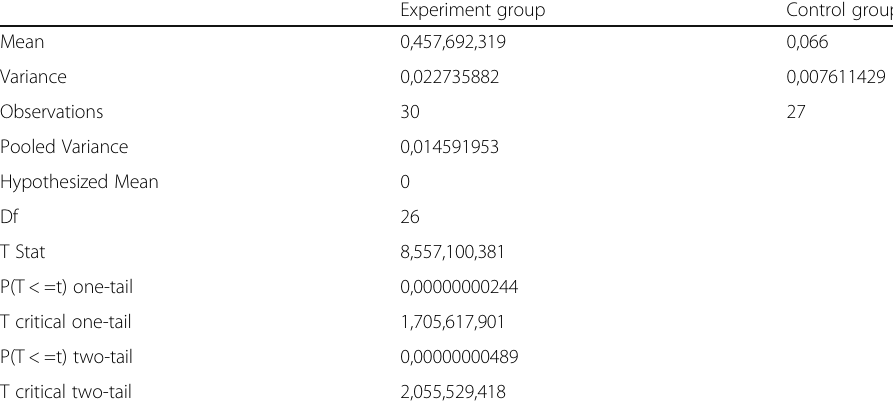
Table 5 The results of t-test comparing experiment group and control group t-Test: two-sample assuming equal variances Experiment group Control group Mean 0,457,692,319 0,066 Variance 0,022735882 0,007611429 Observations 30 27 Pooled Variance 0,014591953 Hypothesized